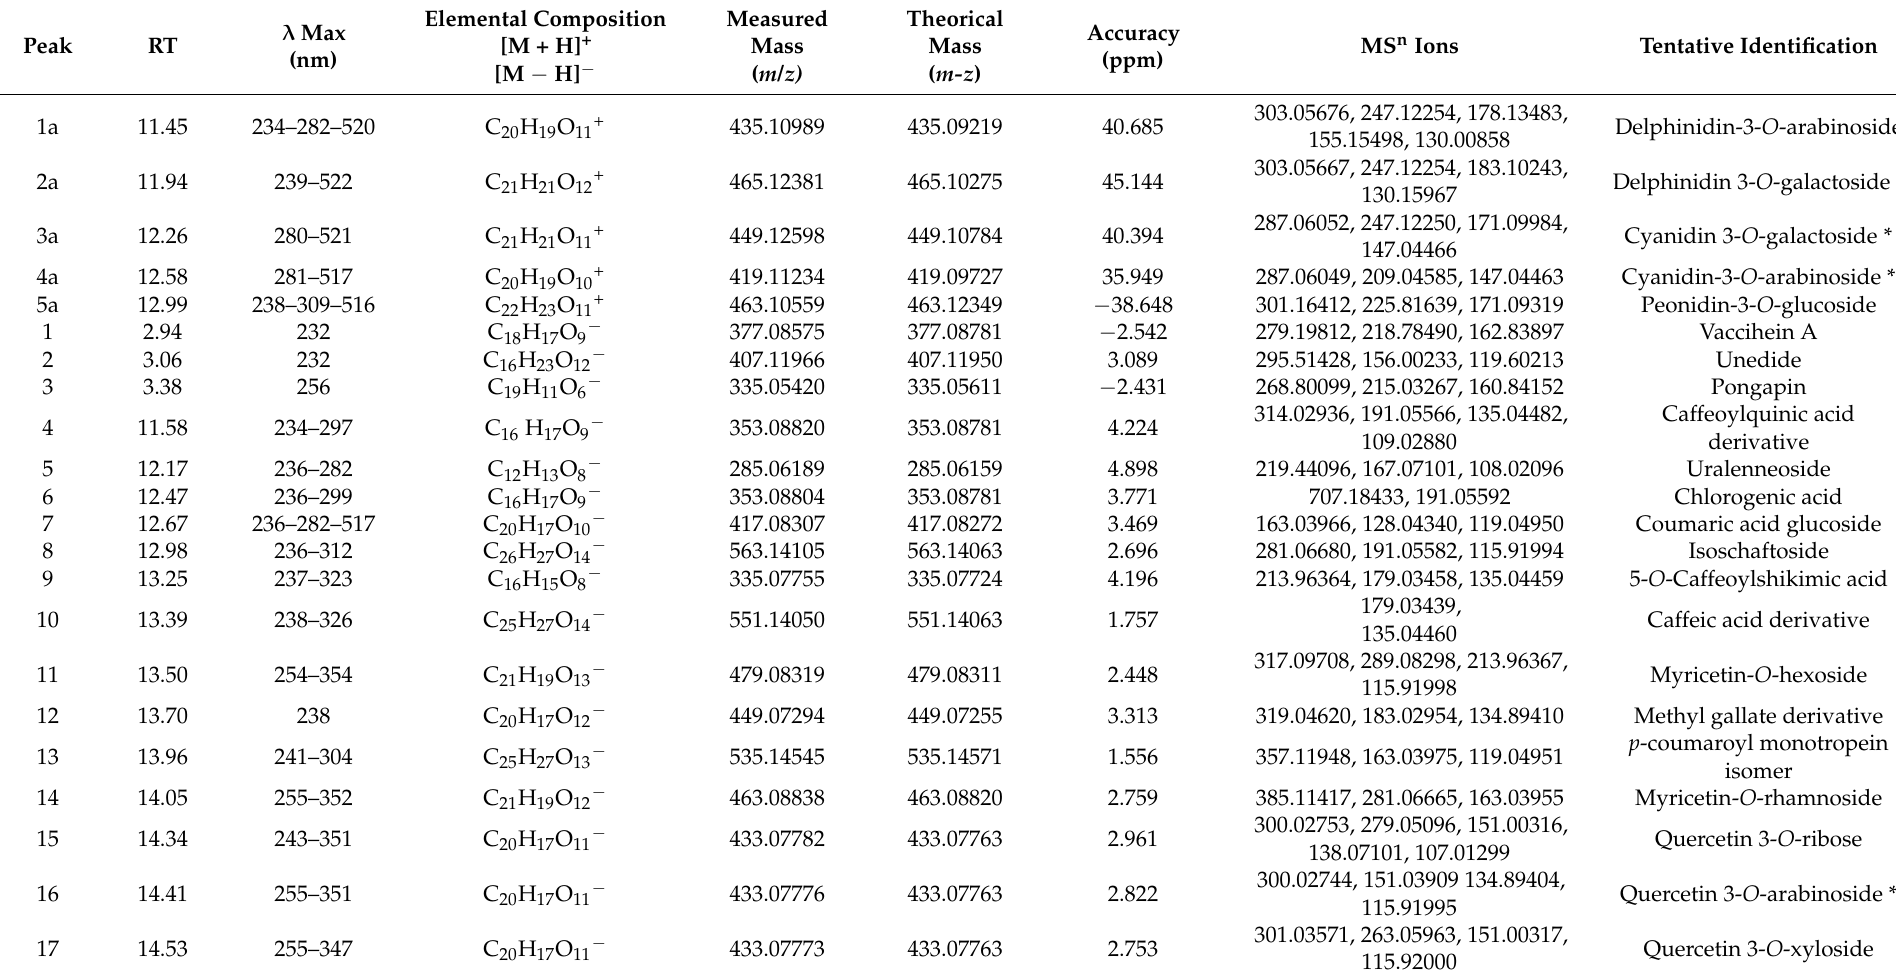
Table 1. Tentative identification of secondary metabolites from Gaultheria pumila